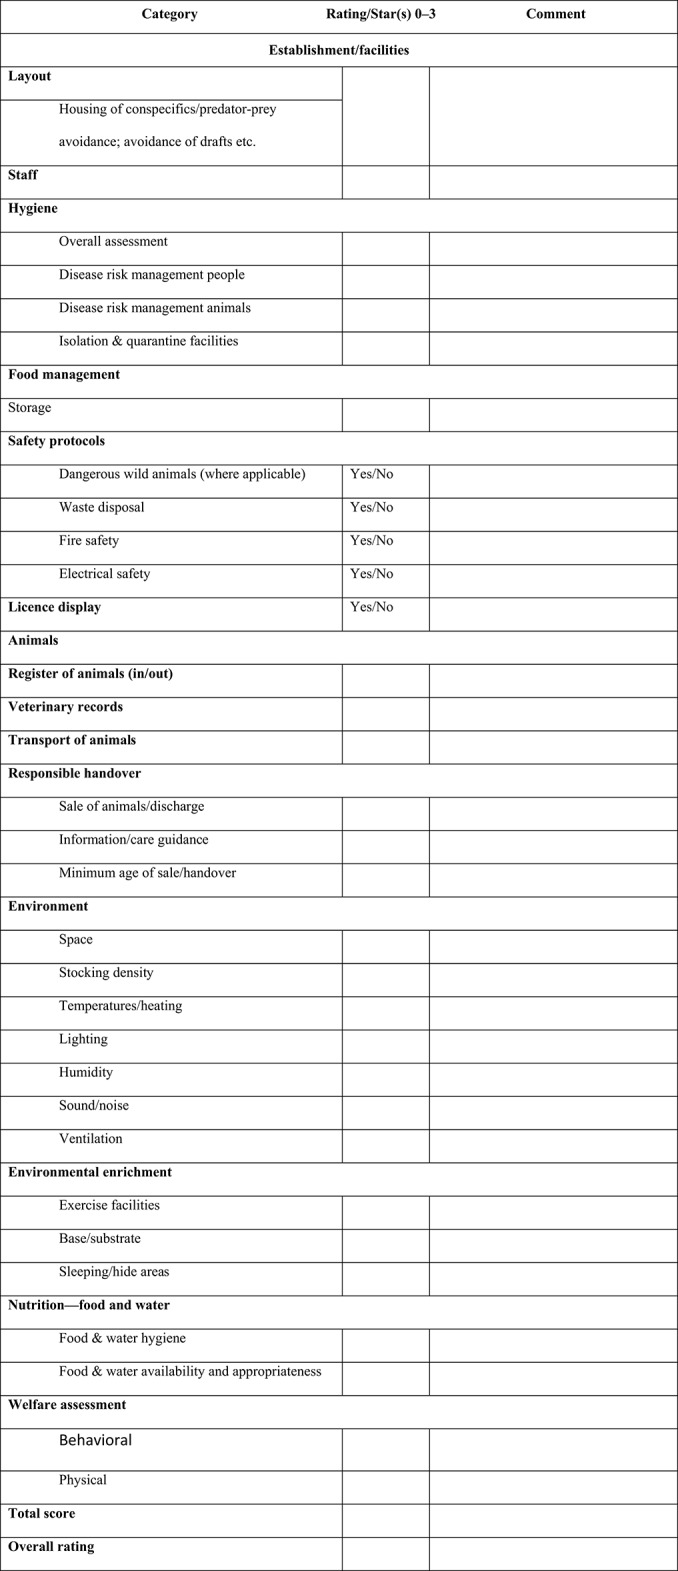
Template: overall performance rating chart for animal establishment.